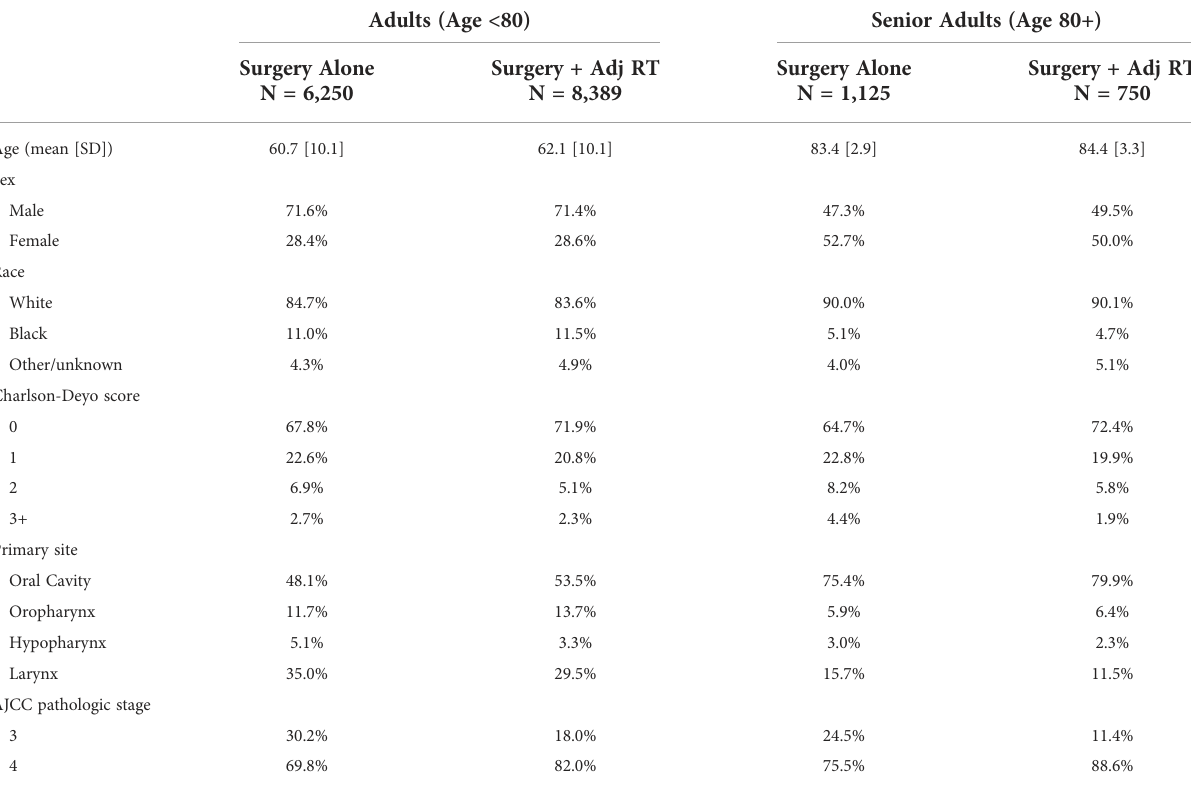
TABLE 1 Patient and tumor characteristics by age group and treatment type.additional analysis of cohort demographics can be found in Table 2 and Supplemental Tables 1, 2.